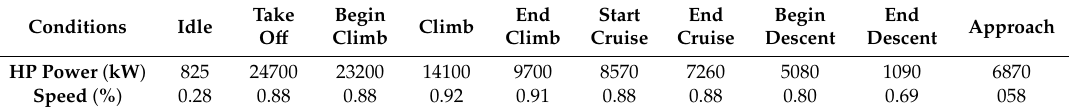
Table 2. Accessory gearbox speed and engine core power during flight